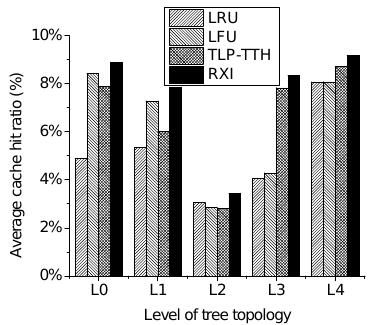
Figure 7. Average cache hit ratio in different levels of hierarchical topology.